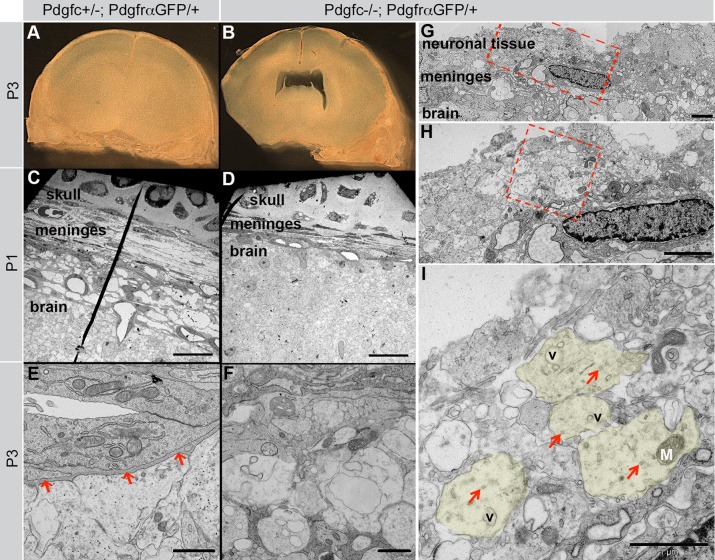
Confirmation of neuronal overmigration in cerebral cortex. (A,B) P3 vibratome sections prepared for TEM studies. The asymmetric lateral ventricles (seen in B) confirm data from Fredriksson et al. (2012). (C-I) Structural analysis with electron microscopy of cerebral meninges from Pdgfc−/−; PdgfraGFP/+and Pdgfc+/−; PdgfraGFP/+ littermate control mice. (C) P1 cerebral meninges. (D) P1 mutant meninges are thin and condensed. (E) High magnification of the area of glia limitans and its basement membrane, in a P3 control mouse. Arrows indicate the basement membrane. (F) Area of glia limitans in a mutant P3 brain, no basement membrane is visible. (G) Neuronal tissue outside the meninges confirms neuronal overmigration in a mutant mouse. Red rectangle is magnified in H. (H) Neuropil outside the meninges. Red square is magnified in I. (I) High magnification of cross cut unmyelinated neurites (out of which some have been colored in light green). V marks vesicles, M marks a mitochondrion and arrows mark microtubule. Scale bars: 20 µm in C,D; 2 µm in E-H; 1 µm in I.